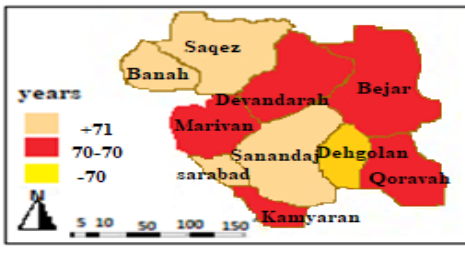
Figure 3. Average life expectancy in rural areas of Kurdistan Province, 2013